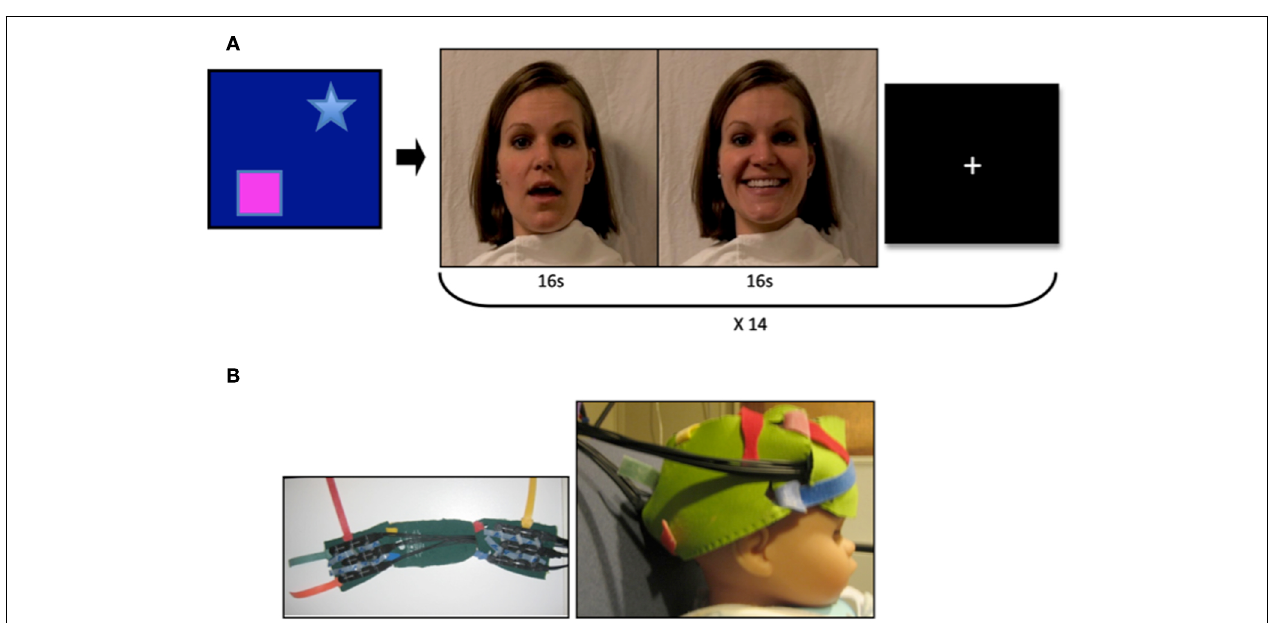
moving objects was used to direct infant attention to the screen at the beginning of the experimental session, and a fixation cross was present between stimulus presentation. (B) Two chevron arrays of probes placed into a custom designed neoprene cap. Probes were placed in the frontal and right lateral panels, and adjusted to proper fit and location with the coloredVelcro